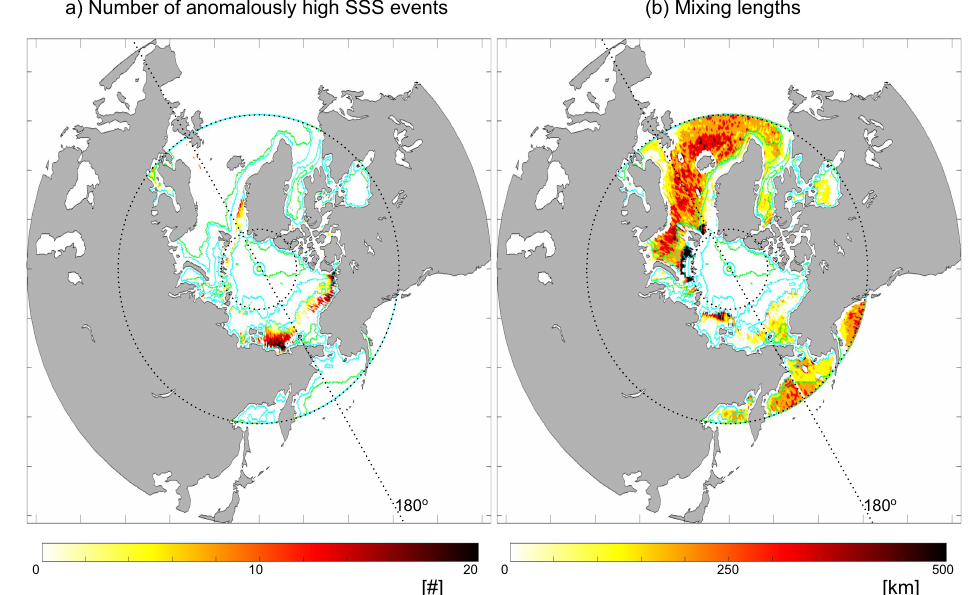
Figure 5. High-latitude satellite sea-surface salinity (SSS) anomalies and trends shown in heat-map colors: ( a ) anomalously high SMAP Level-2 SSS product sea-surface salinity (SSS) for the period April 2015 to December 2020, computed by counting the number of 8-day averages where the average SSS is exceeded by more than three times the SSS standard deviation; and ( b ) the mixing length scales calculated as the ratio of the temporal standard deviations from Level-2 SMAP SSS data (April 2015 to December 2020) to the horizontal spatial gradients of SSS from the Level-3 daily Earth & Space Research SMOS product (January 2011 to December 2020). The cyan (green) contours in each panel indicate the minimum (maximum) sea ice extent over all winters between 2015–2019. Overlaid on top are geographical coordinates indicating where the 0 ◦ and 180 ◦ meridians, as well as the 55 ◦ N and 80 ◦ N latitudes